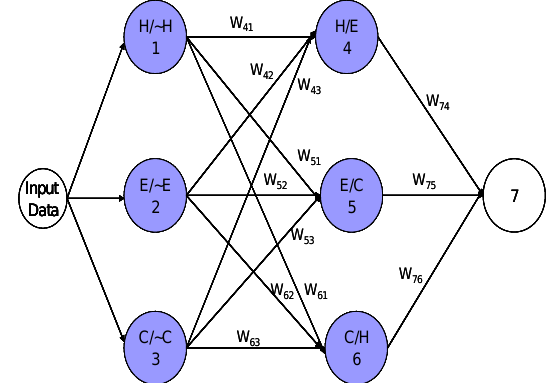
Figure 1 Evolutionary Neural Support Vector Machines In the formulations the output of the second hidden layer is formed by adding the output of the SVM (sitting inside the neuron) with the product of the weight and output of the corresponding neuron (i.e. the neuron which positively classifies the same class as the current neuron) and by subtracting the products of the other two neurons in the first